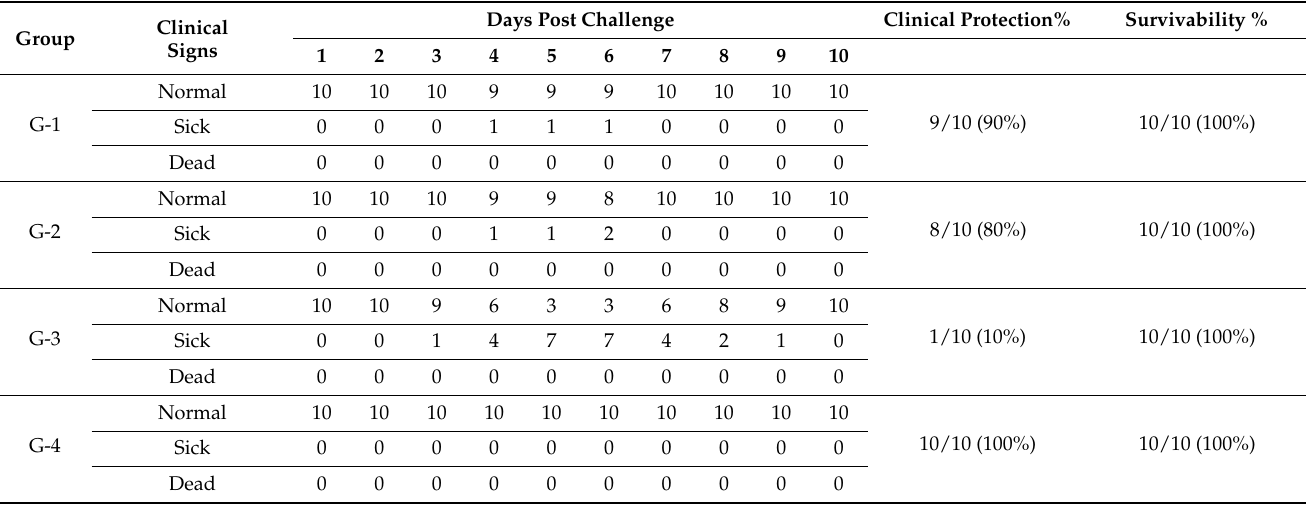
Table 2. Development of clinical manifestations during 10-days